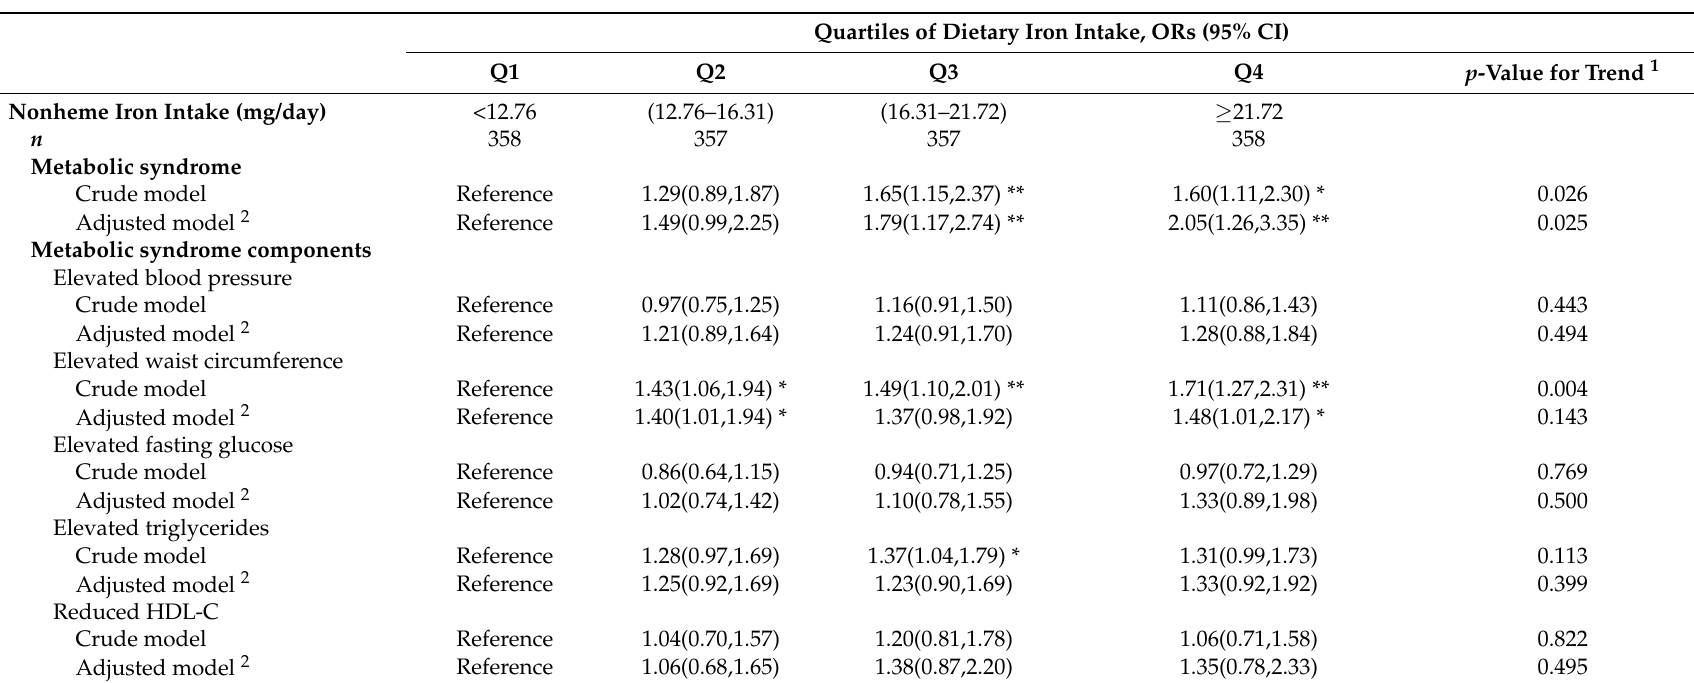
Table 7. ORs (95% CI) for metabolic syndrome and its components according to the quartiles of nonheme iron intake (mg/day) among men in the SDHS